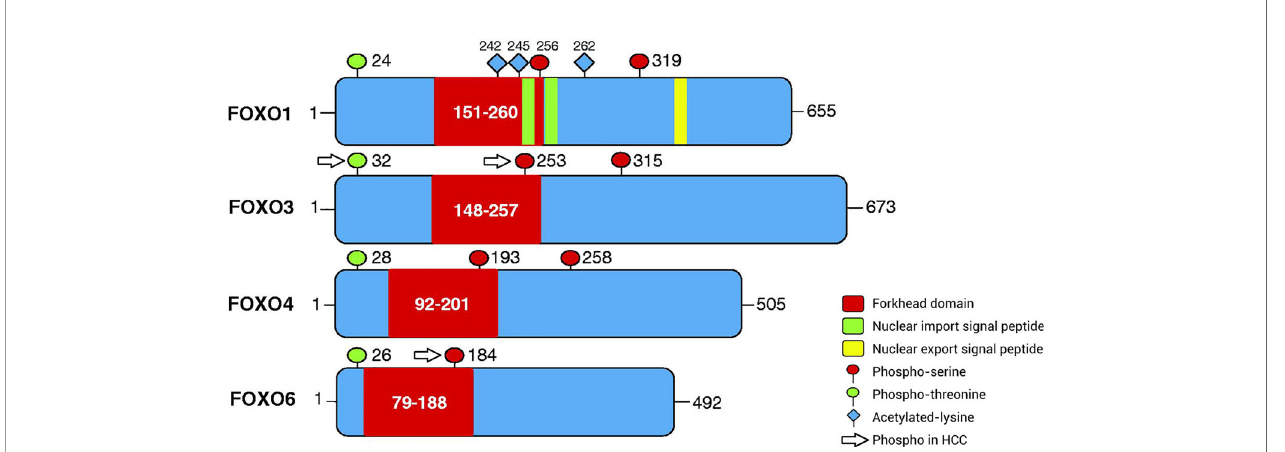
FIGURE 1 | Patterns of post-translational modi fi cation of FOXO proteins via phosphorylation. The amino acid sequence of FOXO proteins has three phosphorylation sites, including phospho-serine and phospho-threonine sites. The fi rst phosphorylation motif is located after the start codon, the second motif is located in the forkhead domain, and the third motif is located immediately following the forkhead domain. However, the third conserved region of FOXO6 is missing. In addition, FOXO1 has special nuclear import/export signal peptides and acetylated lysine residues. The phosphorylated sites of FOXO proteins in HCC are separate and include ubiquitination and phosphorylation at Ser253 in FOXO3, phosphorylation at Thr32 in FOXO3, and phosphorylation at Ser184 in FOXO6. FOXO, Forkhead box O